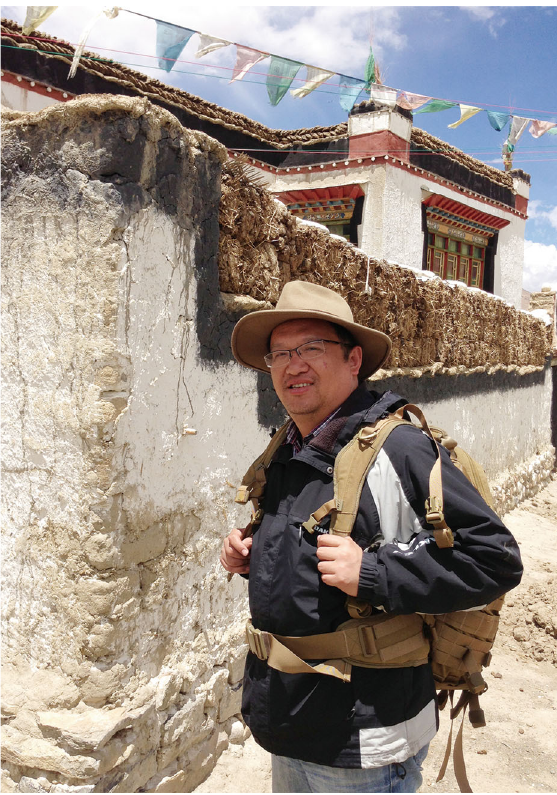
Figure 1. Dr. Yang Zhong: An explorer on the road forever.